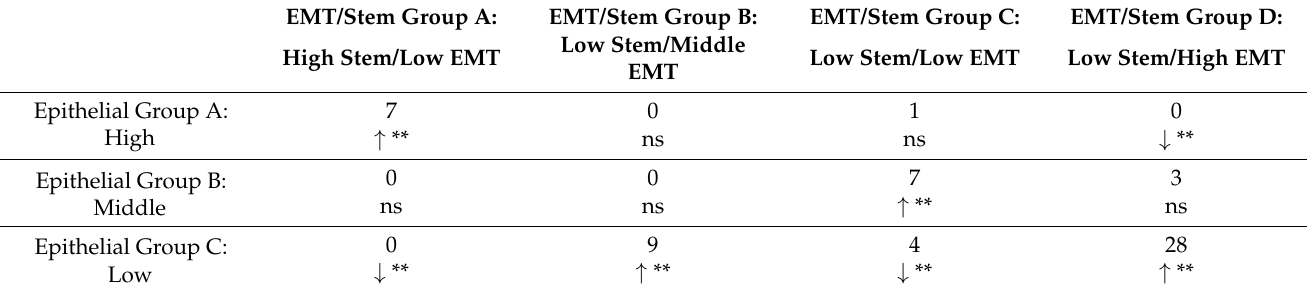
Table 1. Correlation between epithelial-cell subtypes and stem/EMT-related subtypes by Chi-square test and residual